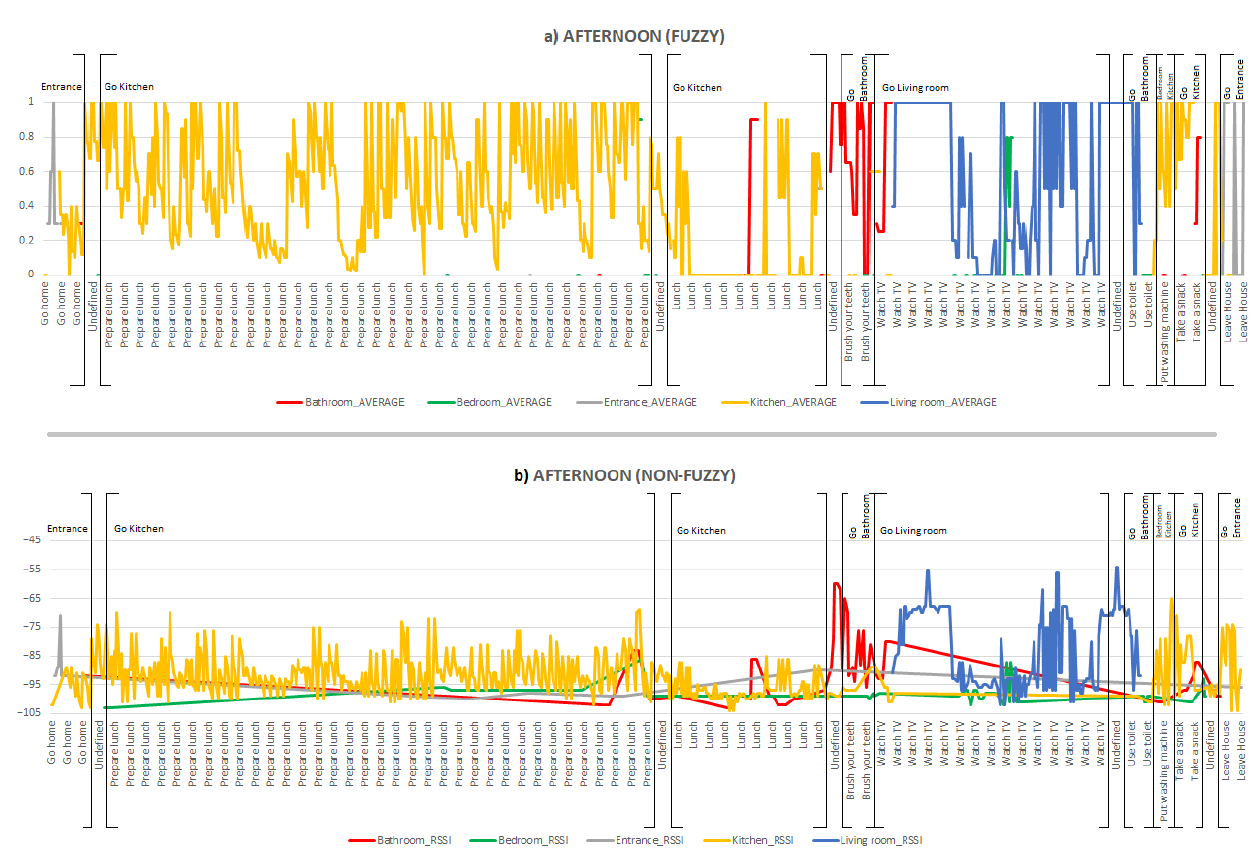
Figure 6. Areas visited and activities carried out by the inhabitant during the afternoon ( a ) with fuzzy processing and ( b ) non-fuzzy (raw